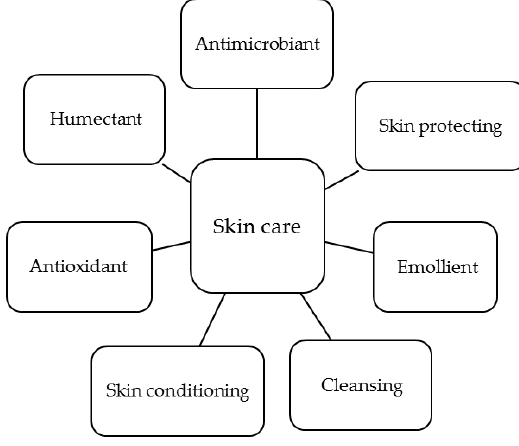
Figure 4. Main functions of chitosan derivatives in skin care.